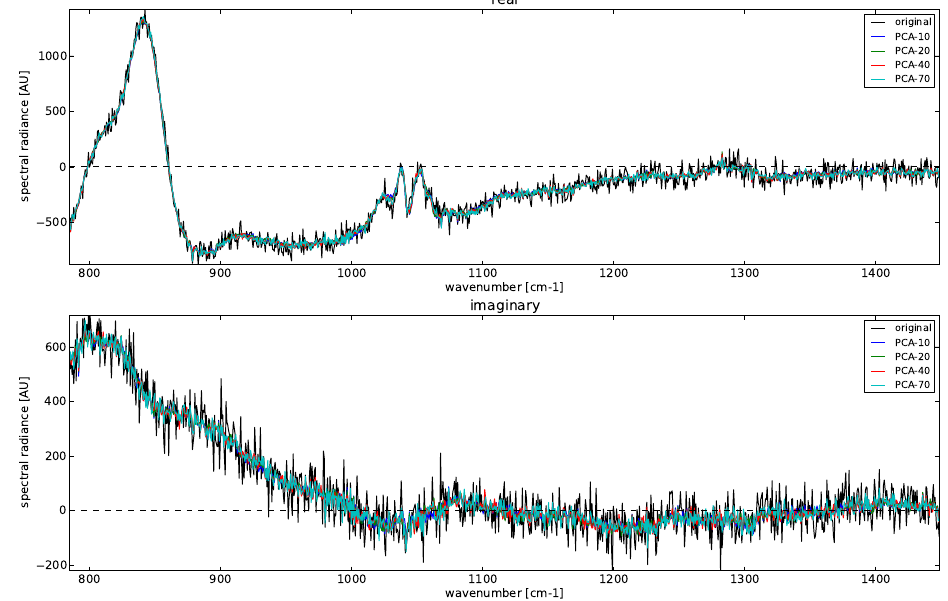
Figure 6. Reconstruction of a DS spectrum (centre pixel) from 10, 20, 40, and 70 principal components.